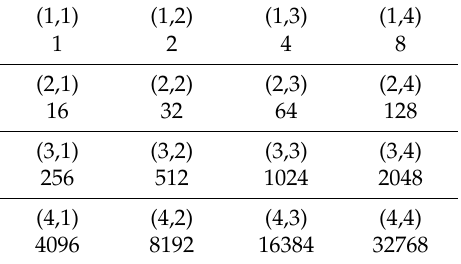
Table 1. Decimal values associated with each matrix position used for the sensors’ power supply.